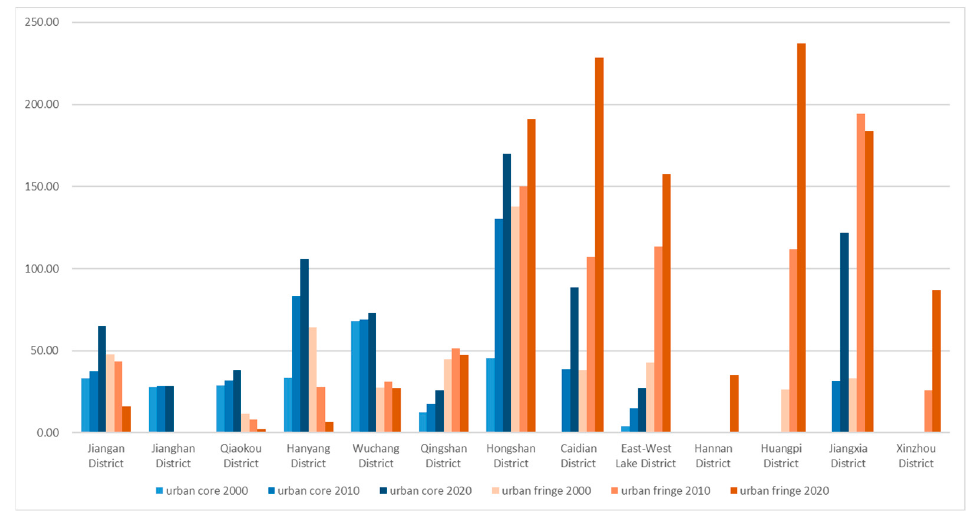
Figure 9. Area histogram of the geographical spatial structure within each administrative region of